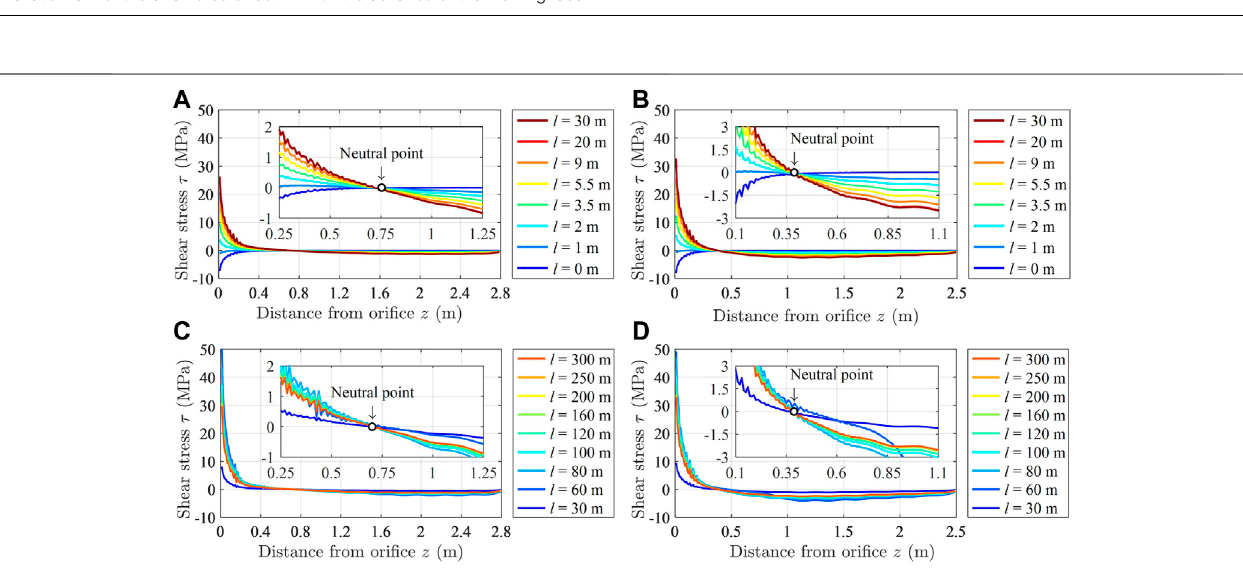
FIGURE11| Distributionlaw ofthe shear stressofthebolt withthebolt body: (A) Variation law oftheshear stressofbolt Awiththeadvanceofthe drivingface; (B) Variation law ofthe shear stress ofbolt B with the advance ofthe driving face; (C) thevariation law of the shear stressof bolt A with theadvance of the working face; and (D) variation law of the shear stress of bolt B with the advance of the working